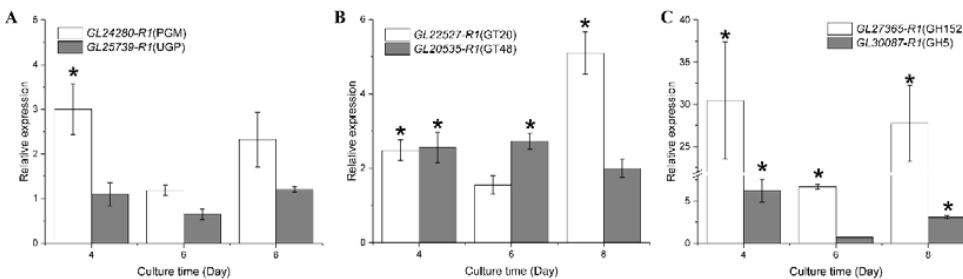
Figure 6. RT-qPCR analysis of genes associated with polysaccharide biosynthesis in Ganoderma lucidum . ( A ) The genes in nucleoside sugar biosynthetic pathway. ( B ) Glycosyltransferases family of genes. ( C ) Glycoside hydrolase family of genes. The statistical analysis used for the xylose group was used as a reference (*: |log 2 (Relative expression)| > 1 and p < 0.05).